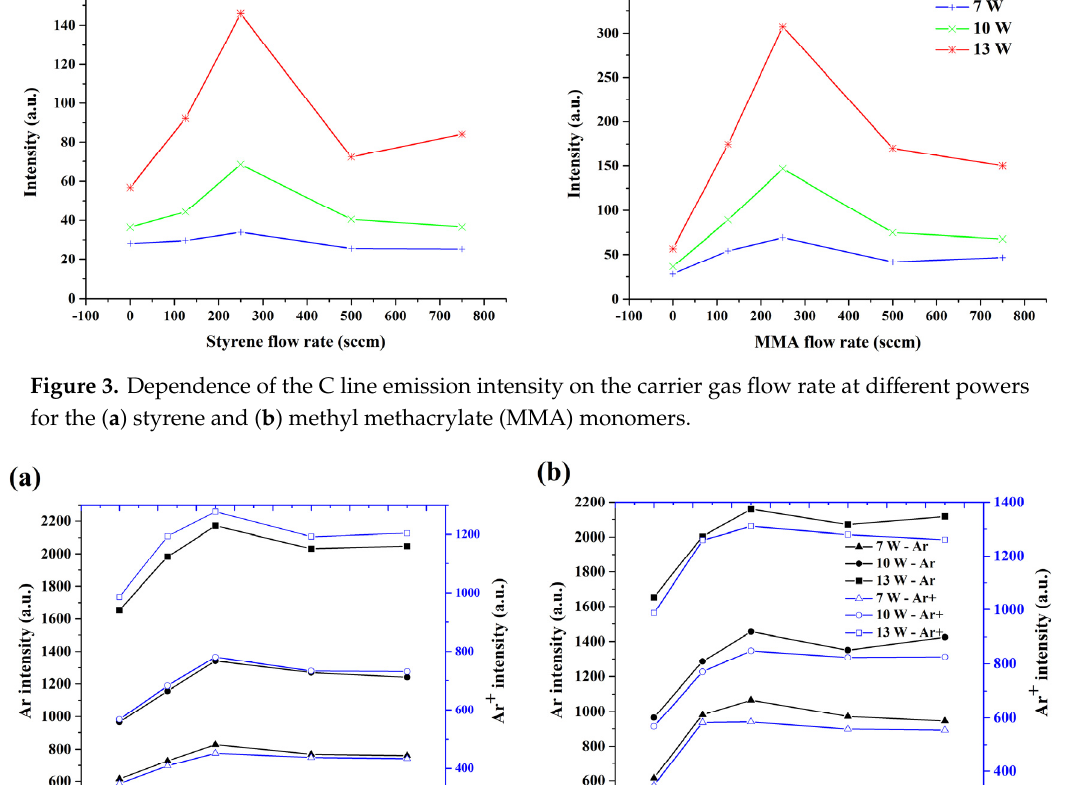
Figure 4. Dependence of the Ar and Ar + line emission intensities on carrier gas flow rate at different applied powers for the ( a ) styrene and ( b ) MMA monomers.